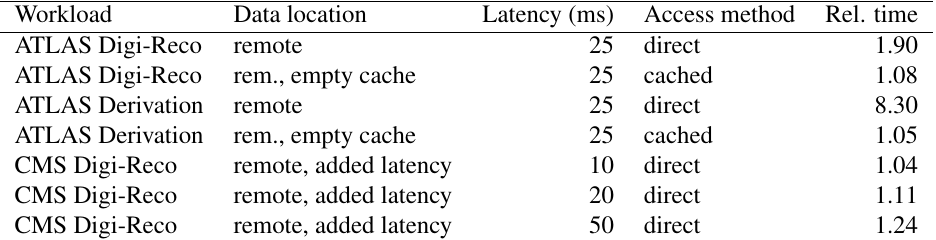
Table 1. Summary of data access studies for di ff erent types of workloads, data location with respect to the processing node, corresponding network latency, access method and relative running time with respect to processing local data; the results show that e ff ective latency hiding can be achieved at the application level (e.g. CMS) or at the caching layer (e.g. ATLAS with a